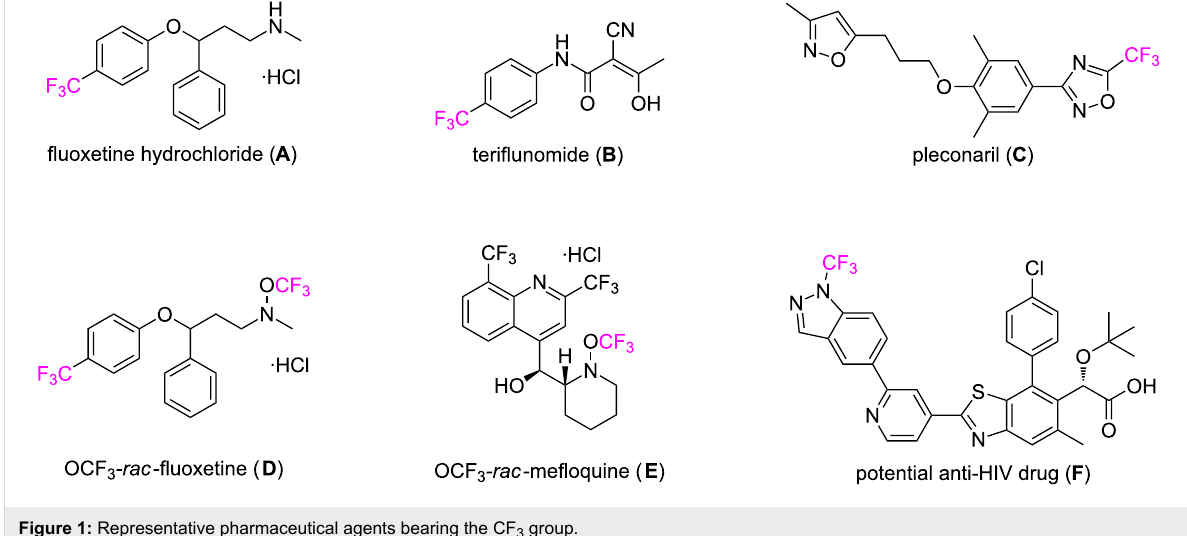
Figure 1: Representative pharmaceutical agents bearing the CF 3 group.